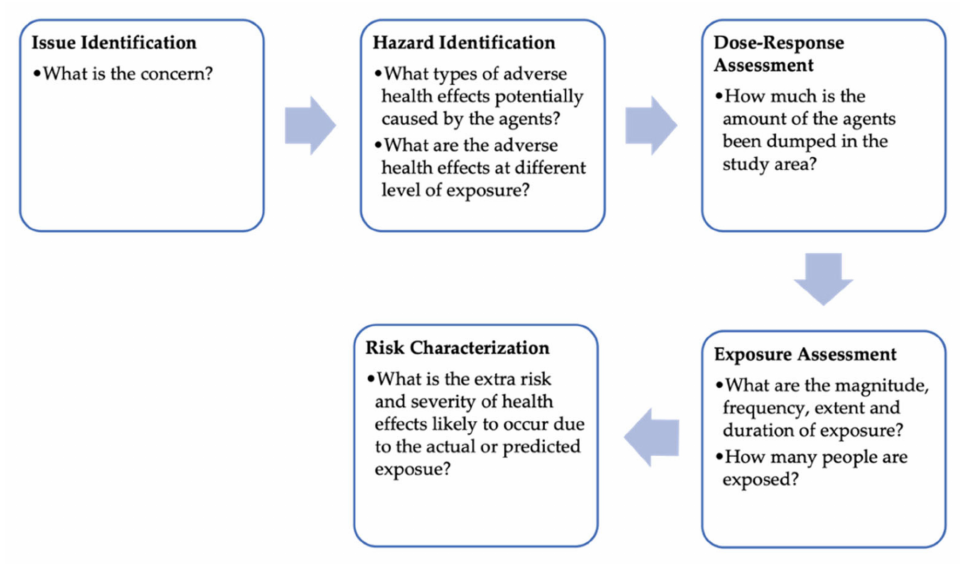
Figure 2. Framework of health risk assessment